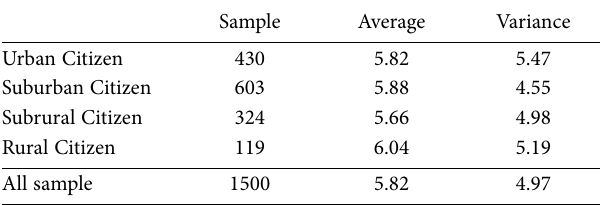
Table 2. Respondents’ reported levels of SWB by